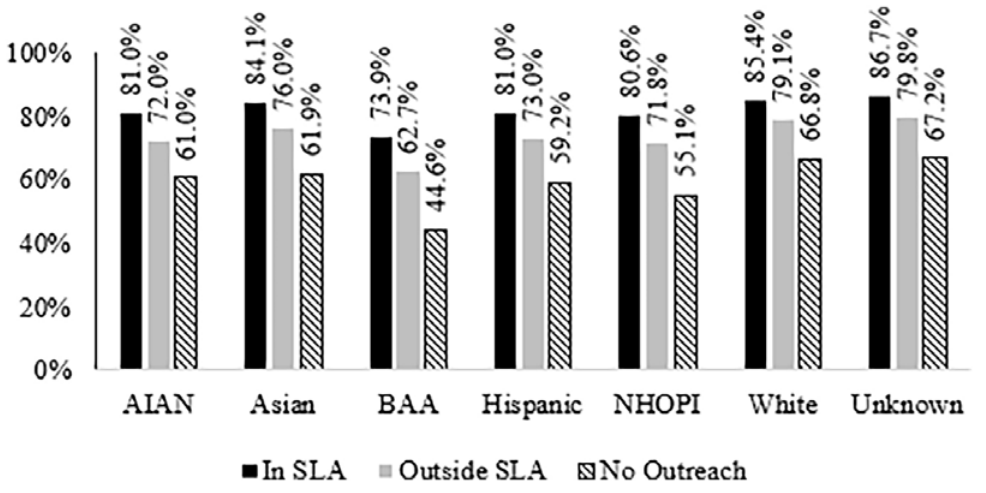
Figure 5. Course Completion Rate by Self- Reported Race/Ethnicity and Service Level Agreement